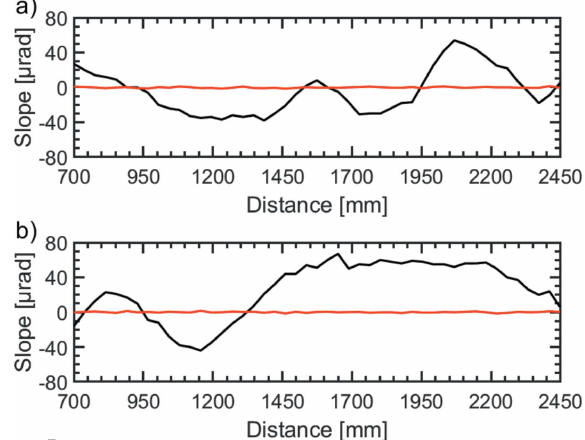
Figure 5 Slope deviation of the mirrors ( a ) DL1 and ( b ) DL2 over the delay range as measured by the interferometric system. The peak-to-valley value of the slope deviation amounts to (cid:2) # = 80 m rad for DL1 and (cid:2) # = 165 m rad for DL2 over the whole delay path. The angular deviation of the beam is compensated by the closed feedback interferometer system acting on the mirrors, yielding a correction precision of (cid:6)# = 0.66 m rad (r.m.s.) (red line, see